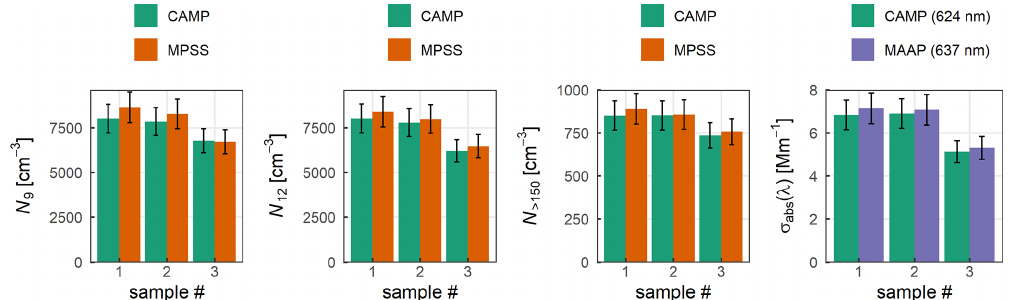
Figure 8. Comparison of averaged particle number concentrations N 9 , N 12 , and N > 150 and particle light absorption σ abs (624nm) with integrated concentrations from MPSS and σ abs (637nm) from MAAP for three time series when CAMP was attached to the balloon on a constant height below 10m on 15 February 2019.